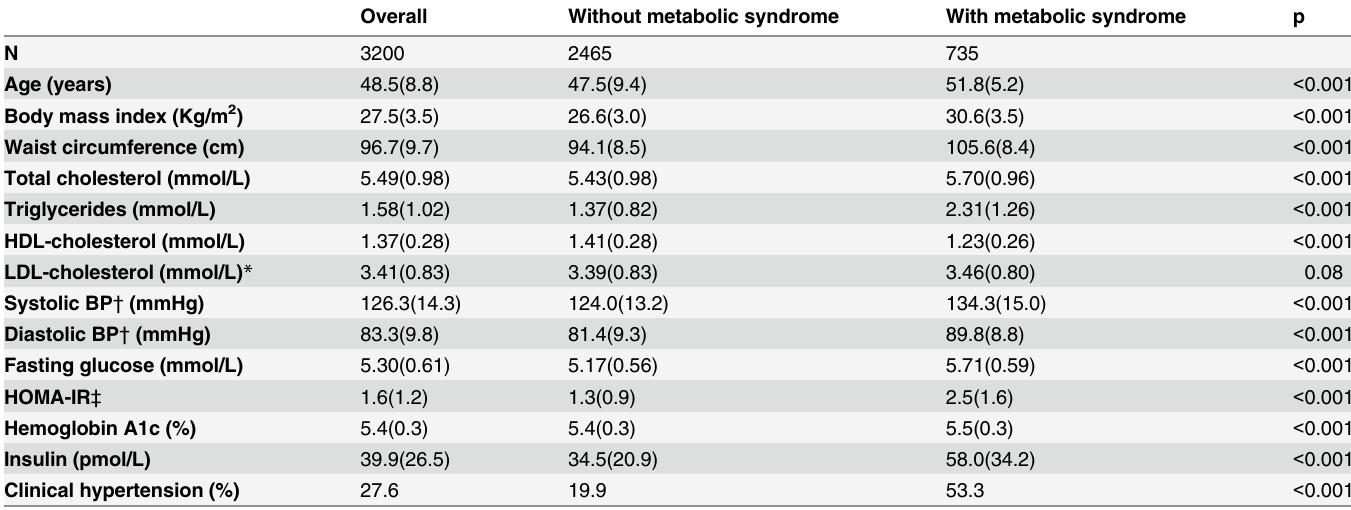
Table 1. Characteristics of the study population with and without metabolic